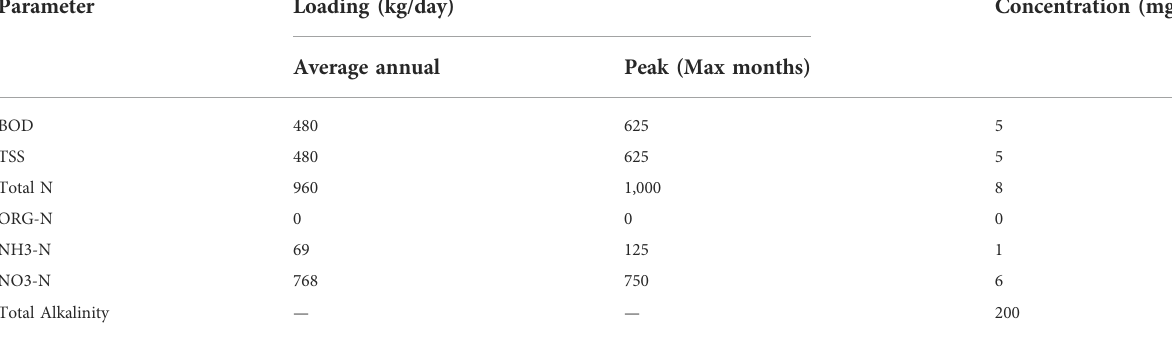
TABLE 2 TE loading rate and concentration of the Al Ansab STP (Source: OWWSC).